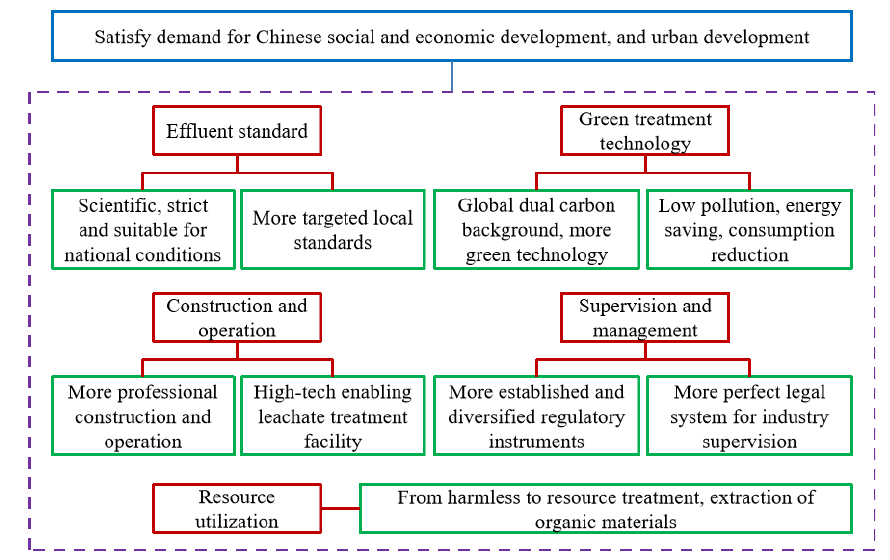
Figure 2. Thumbnail of future leachate development